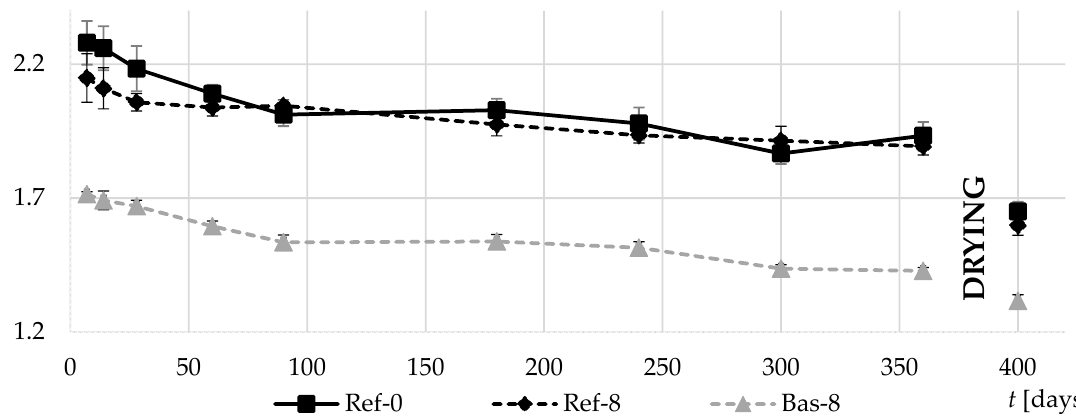
Figure 10. Thermal conductivity coefficients in the first 360 days of composites curing and after additional drying.